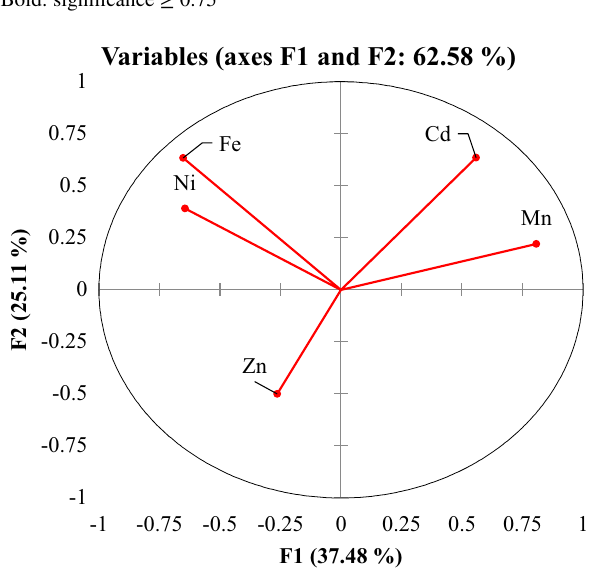
Fig. 6 variable chart of sample